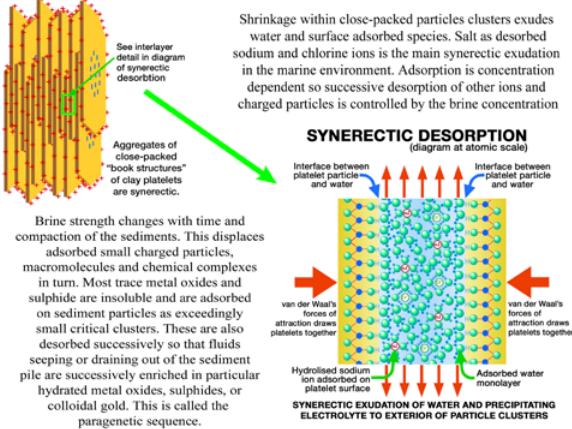
Figure 72. Shrinkage within close-packed clusters of sediment com- ponent such as clay accretions exudes water and surface adsorbed minute hydrated sulphide or oxide particles called critical clusters. These are desorbed into the fluid phase and are small enough (8 to 15 Angstroms) to diffuse out through very small sediment pores. Salt is desorbed as sodium and chlorine ions and it is the main com- ponent of fluid exudation from marine sediments. Adsorption of other species is controlled by the brine concentration. Adsorption is dependent on concentration and small charged particles cannot compete for adsorption sites at high concentration of Na + or Cl -